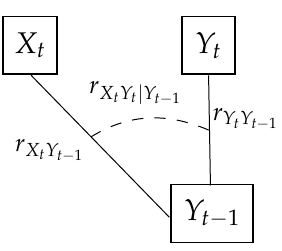
Figure 1. Vine representation of a joint distribution in 3